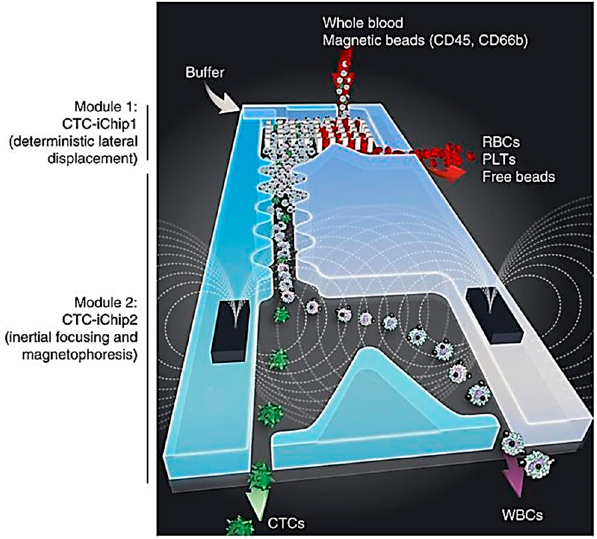
Figure 3. Schematic representation of CTC iChip showing two stages: (1) iChip1 uses the LDL technique for separating red blood corpuscles (RBCs), platelets (PLTs) and free beads from the whole blood; (2) iChip2 uses magnetophoresis for separating CTC from white blood cells (WBCs). Reprinted with permission from [59]. Copyright (2014) Springer Nature.